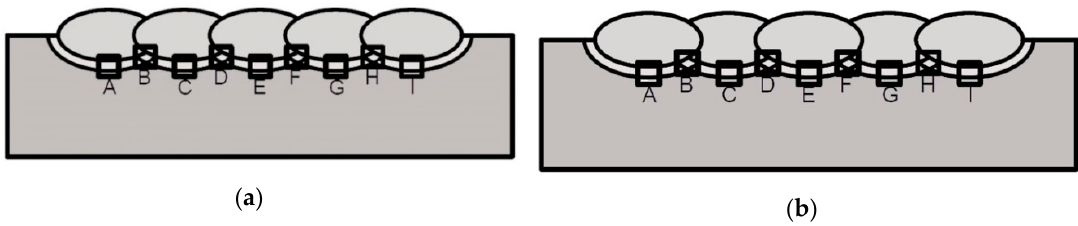
Figure 3. Schematic view of areas of microscopic testing: ( a ) specimen S1, ( b ) specimen S2.